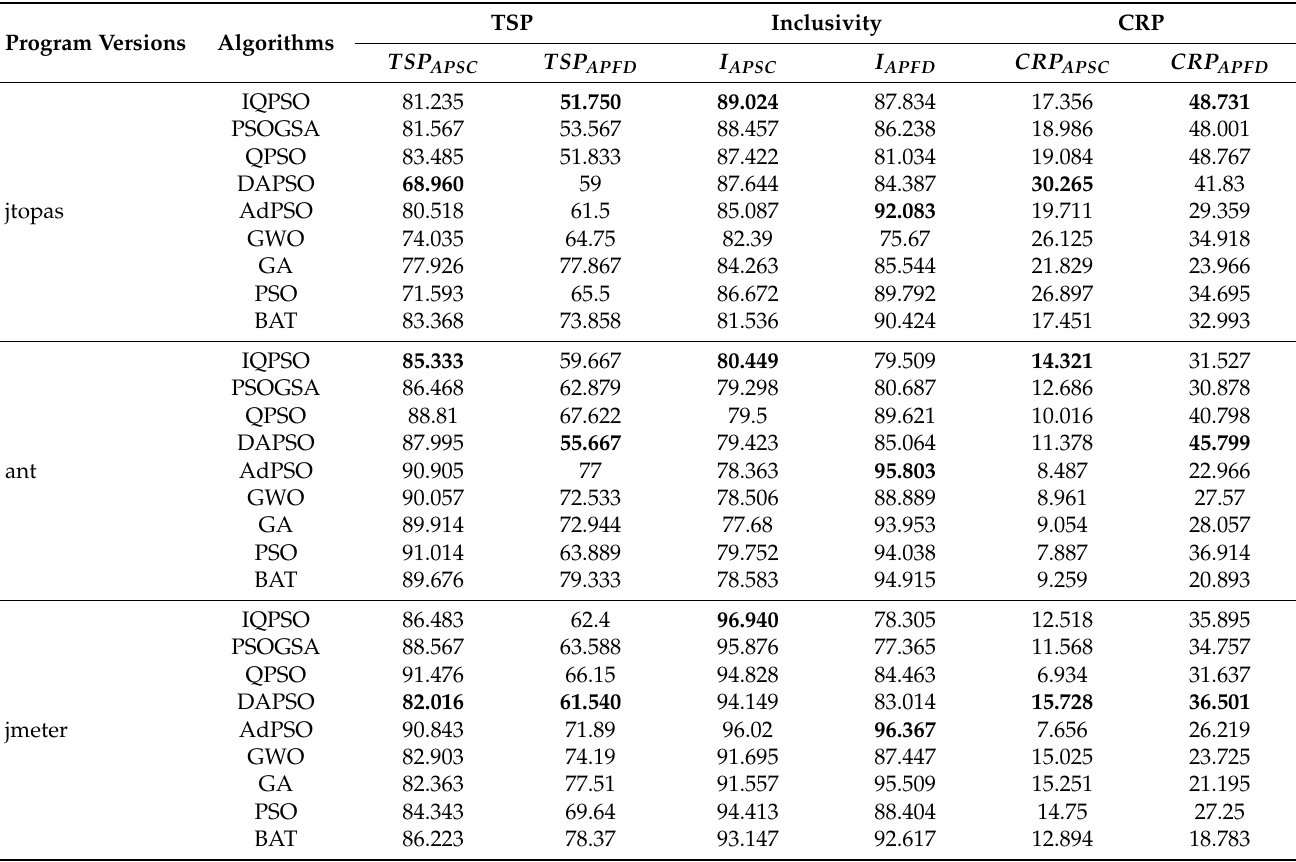
Table 5. Comparisons of the algorithms for TCS over fault and statement